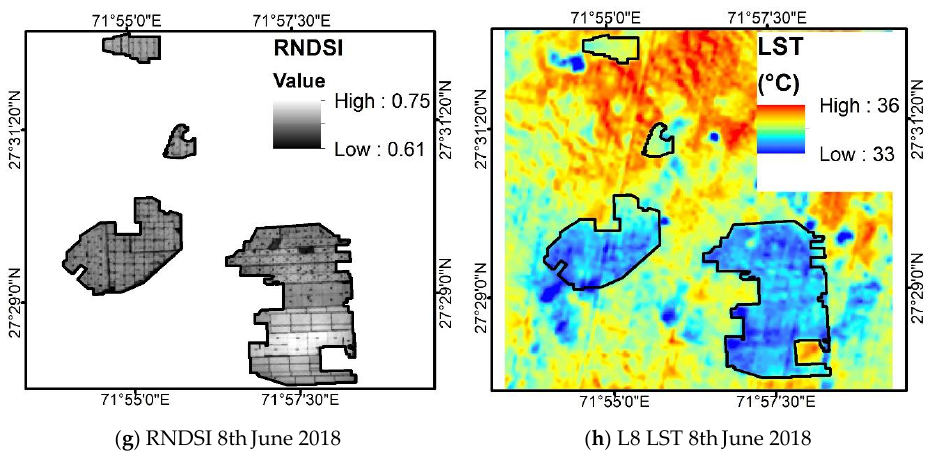
Figure 8. Landsat 8 spatial distribution of soiling patterns using ratio normalized difference soil index (RNDSI) along with LST at different times after the installation of panels. The figure shows results of RNDSI in Figure 8( a ), 8( c ), 8( e ), 8( g ) with LST in Figure 8( b ), 8( d ), 8( f ), 8( h ) respectively.